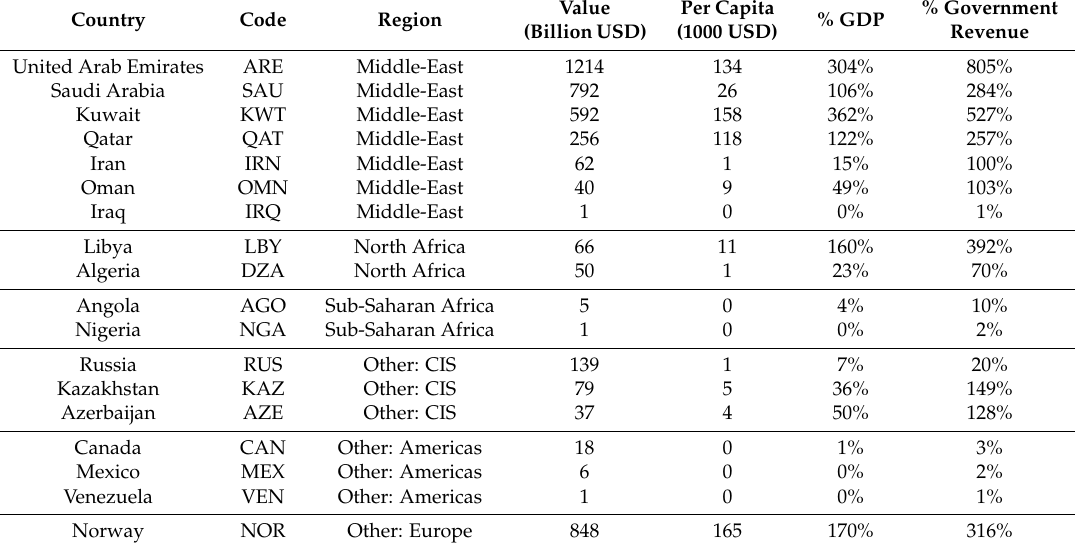
Table 2. Oil-related sovereign wealth funds (SWFs) (2014). Data sources: Oil-related SWFs [24], population [21], GDP [25], government revenue [26]. SWFs taken into account: ARE (ADIA, ICD,